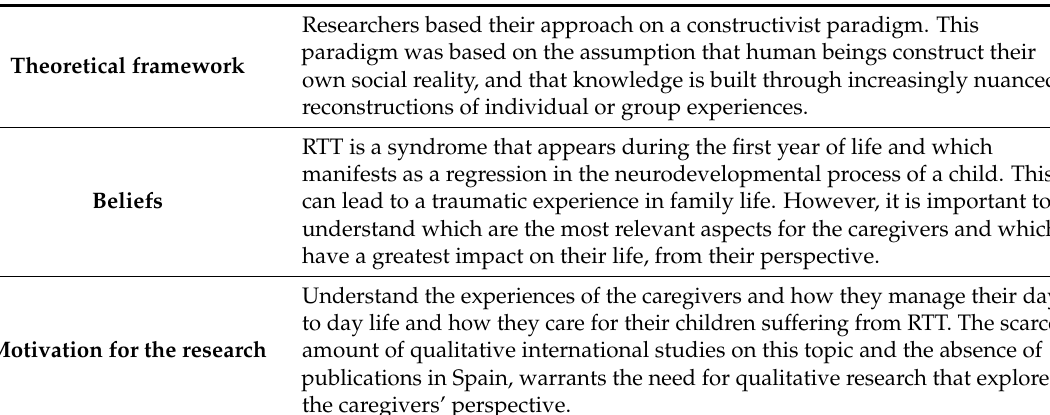
Table 1. The positioning of the